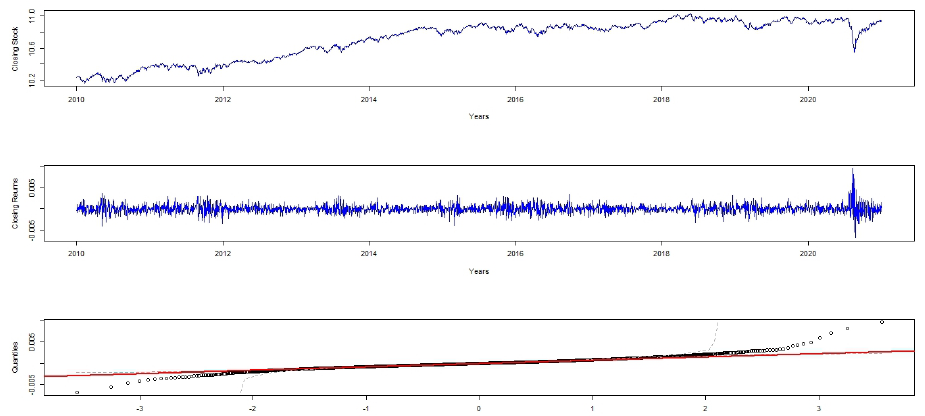
Figure 1. Presents plots of original FTSE/JSE-ALSI, the logarithm returns on FTSE/JSE–ALSI, and normal Q-Q plot for intra-day returns on